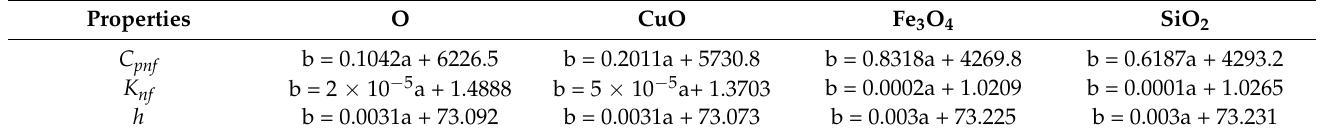
Table 1. Thermophysical properties as a function of magnetic field forces in Gauss.